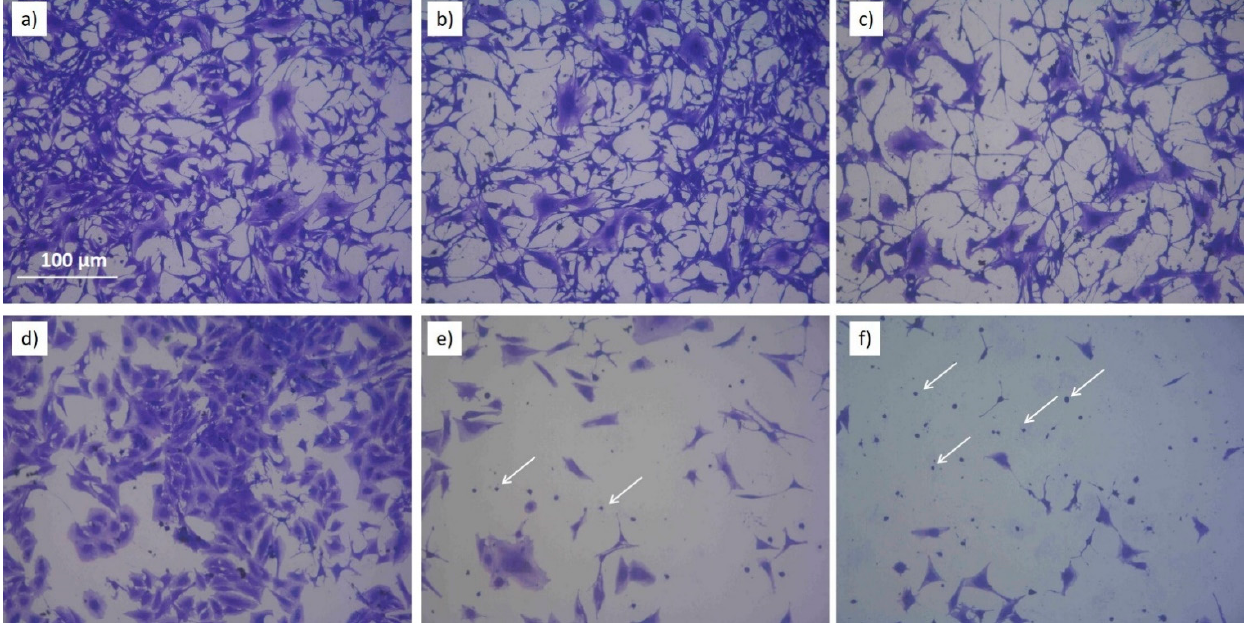
Figure 9. Coomassie Blue images of Eahy926 ( a – c ) and Saos2 ( d – f ) cells incubated with PTWS and let grown for 72h. Cells no incubated with PTWS are shown in ( a , d ). ( b , e ) show cells incubated with ( − )H 2 O 2 ( − )NO 2 − . ( c , f ) show cells incubated with (+)H 2 O 2 (+)NO 2- . White arrows in images ( e , f ) show spherical Saos2 cells.